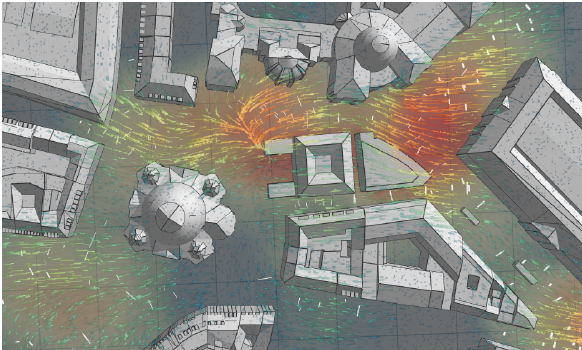
Figure 4. Statistical visualizations of images taking their positions and orientations into